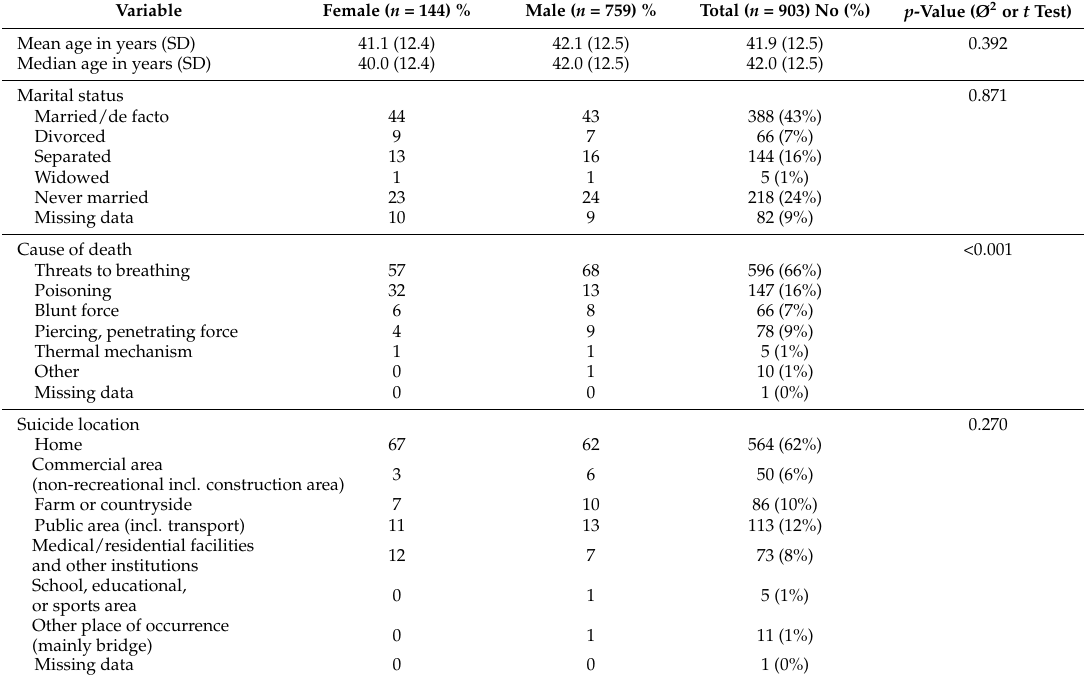
Table 4. Profile of fatality by suicide for those